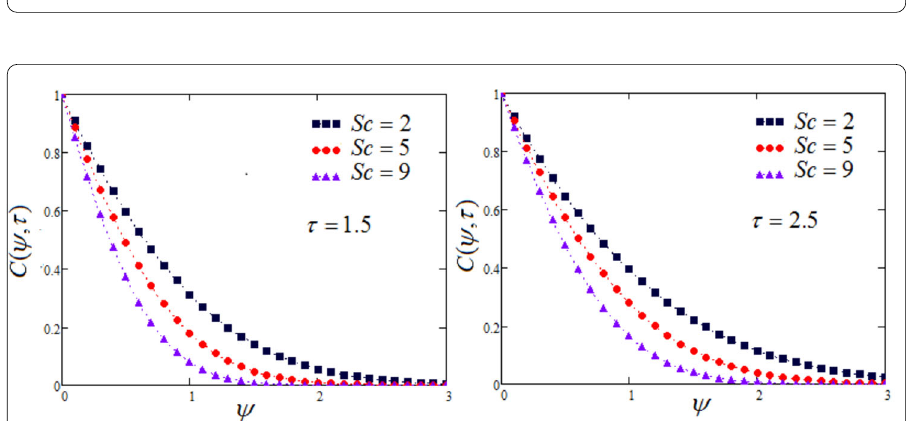
Figure 3 Temperature profiles of a Maxwell fluid for various values of Pr at two different times